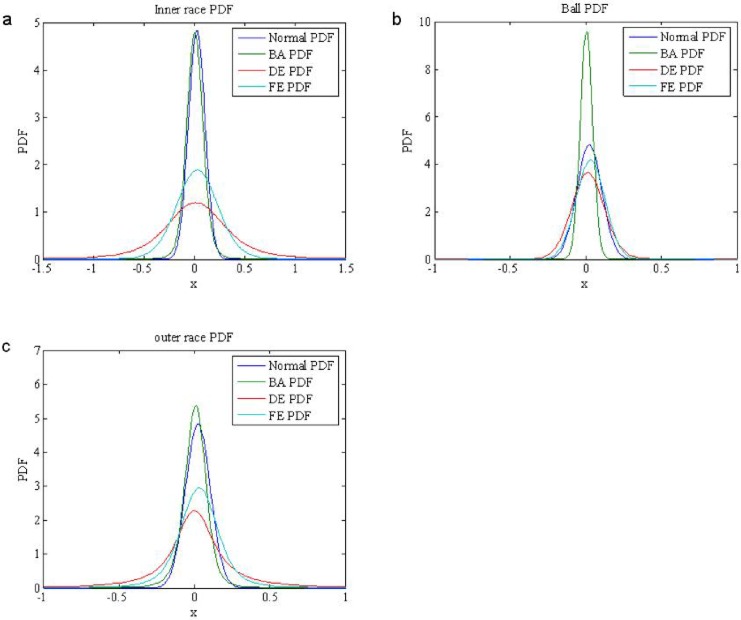
PDFs of the bearing fault signals (a) PDFs of inner race fault in DE, FE and BA (b) PDFs of ball fault in DE, FE and BA (c) PDFs of outer race fault in DE, FE and BA.